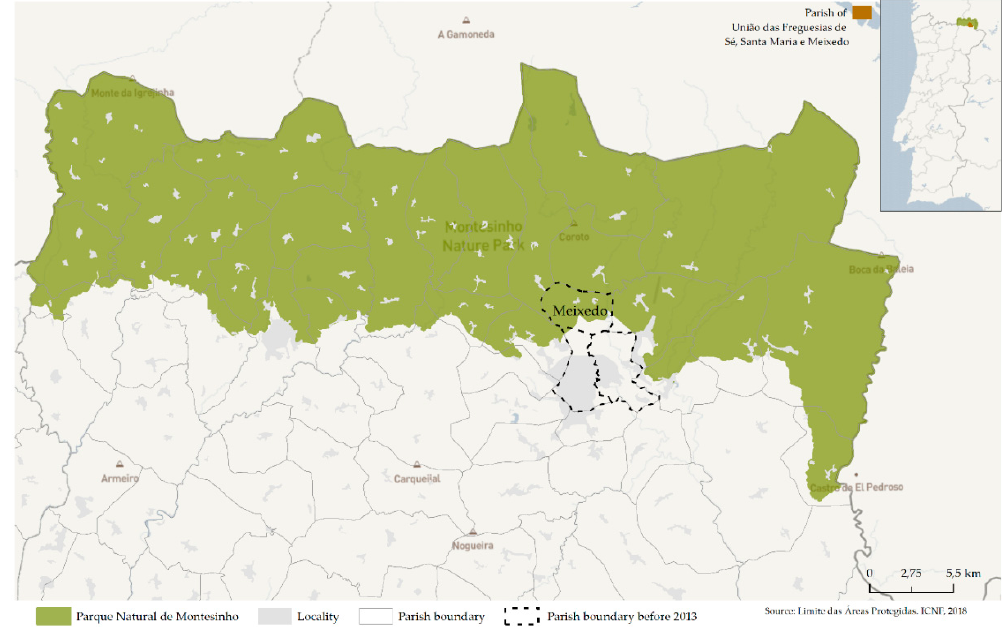
Figure 12. Parque Natural de Montesinho and the parish of União das Freguesias de Sé, Santa Maria e Meixedo.